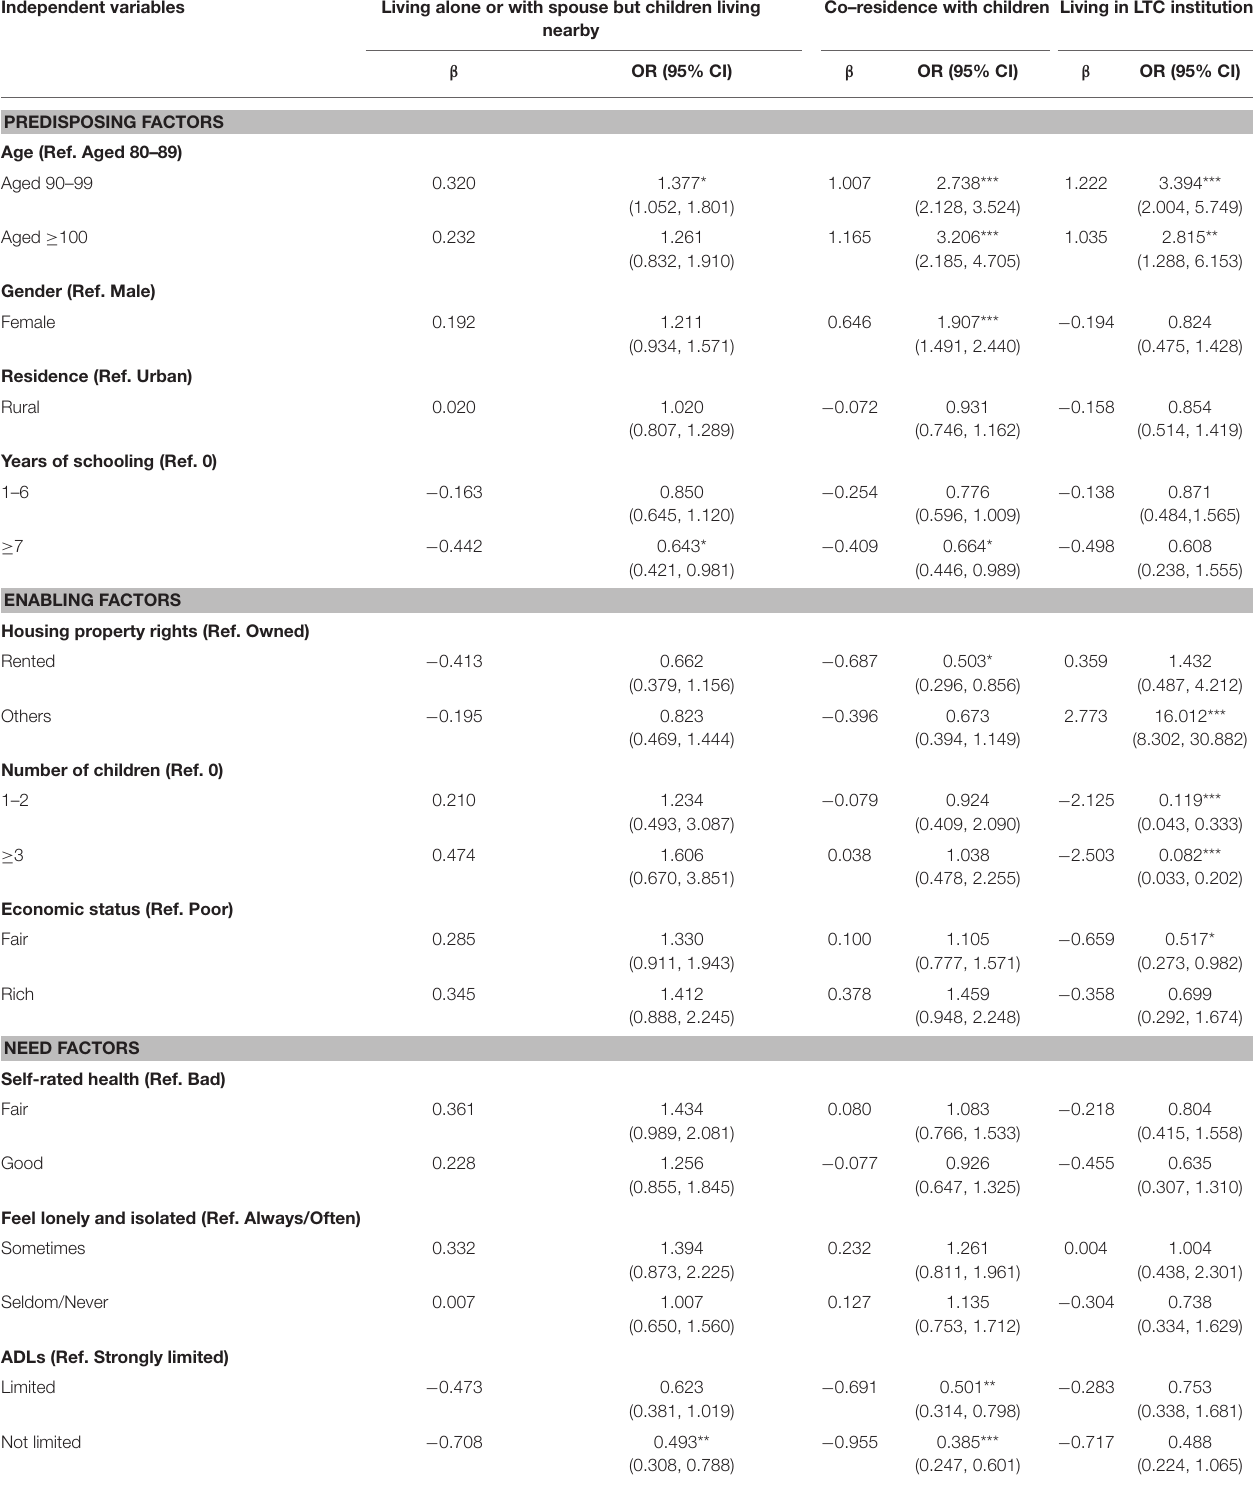
TABLE 4 | Anticipated living arrangement for the oldest old (multivariate logistic regression). Independent variables Living alone or with spouse but children living